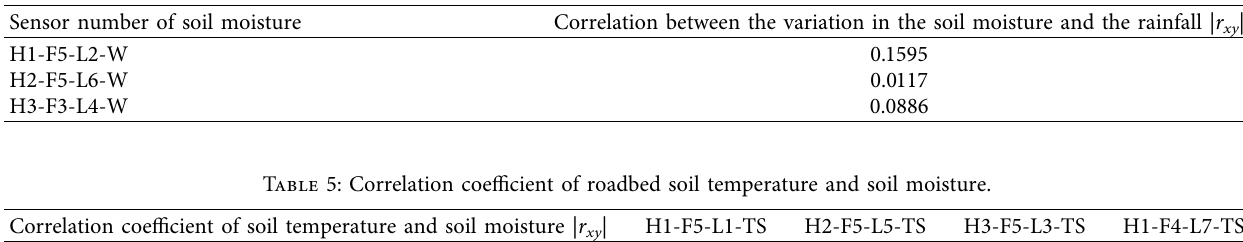
Table 4: Correlation between the variation in the soil moisture and the rainfall.